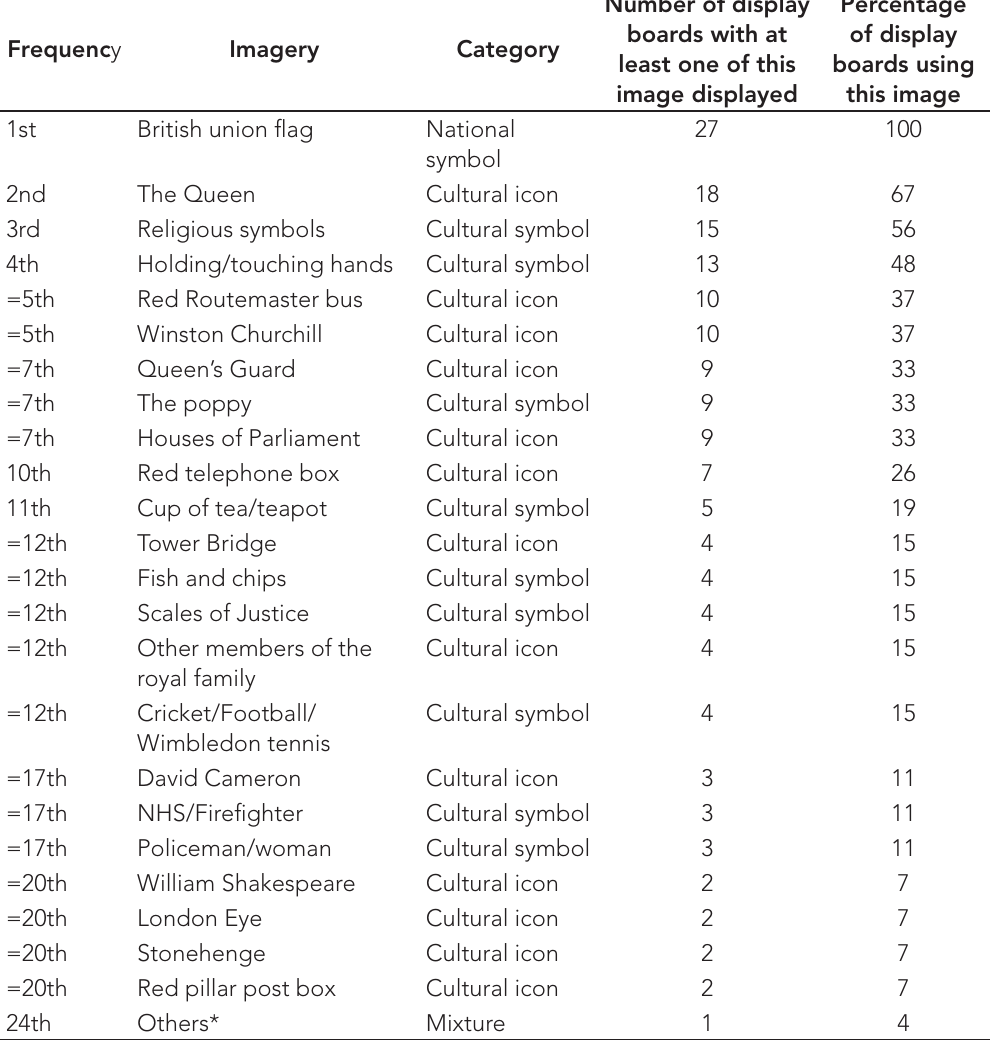
Table 1: Images that represent fundamental British values on primary school display